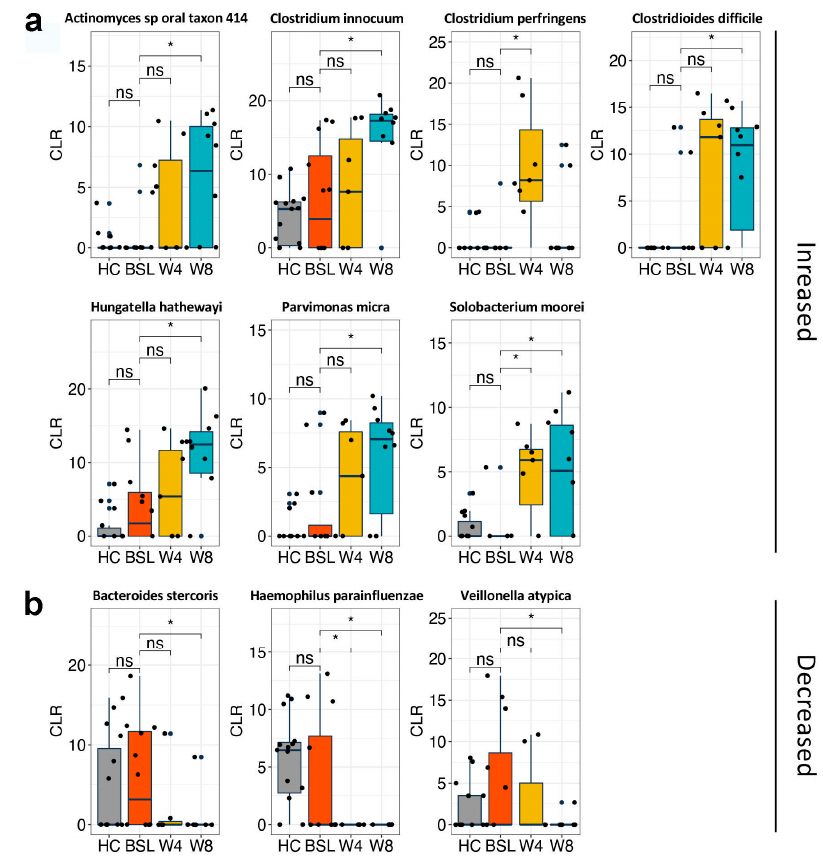
Figure 6. Metagenomic analysis of gut microbiota profiles in CD patients before and after EEN induction therapy. Boxplots demonstrate significantly increased ( a ) and decreased ( b ) bacterial species after either 4 w or 8 w of EEN therapy. Significance was determined via Welch’s t -test based on CLR-transformed counts. * p < 0.05. HC, healthy controls; BSL, baseline; CLR, centered log-ratio.